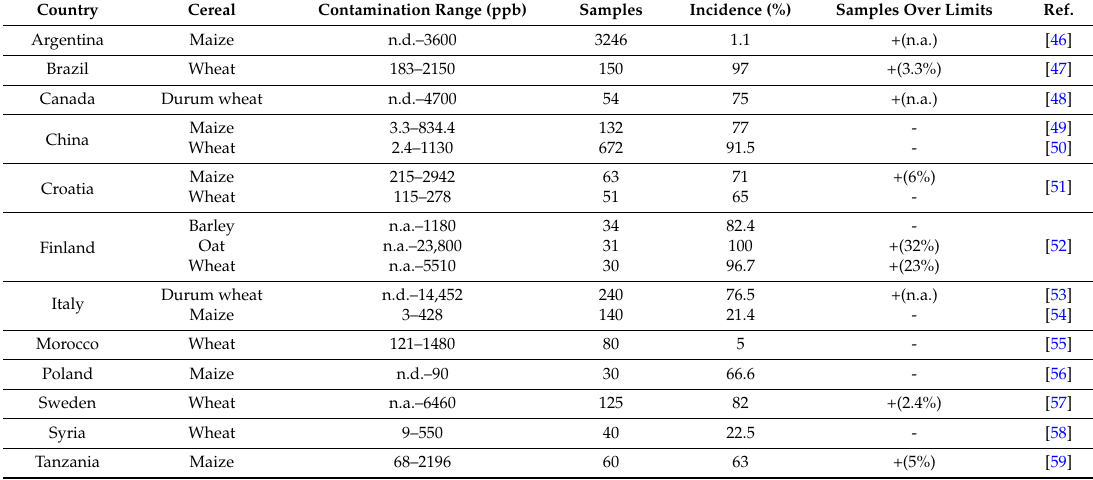
Table 1. Percentage and level of contamination in different countries and commodities relative to deoxynivalenol.